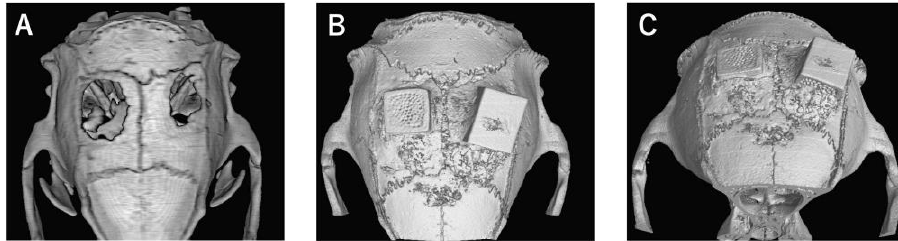
Figure 4. Analysis of bone formation on honeycomb β -TCP in micro CT image in Collagen gel group at 4 weeks after implantation. ( A ) Bone defect group. ( B ) Collagen alone group. ( C ) Collagen + BMP-2 group.